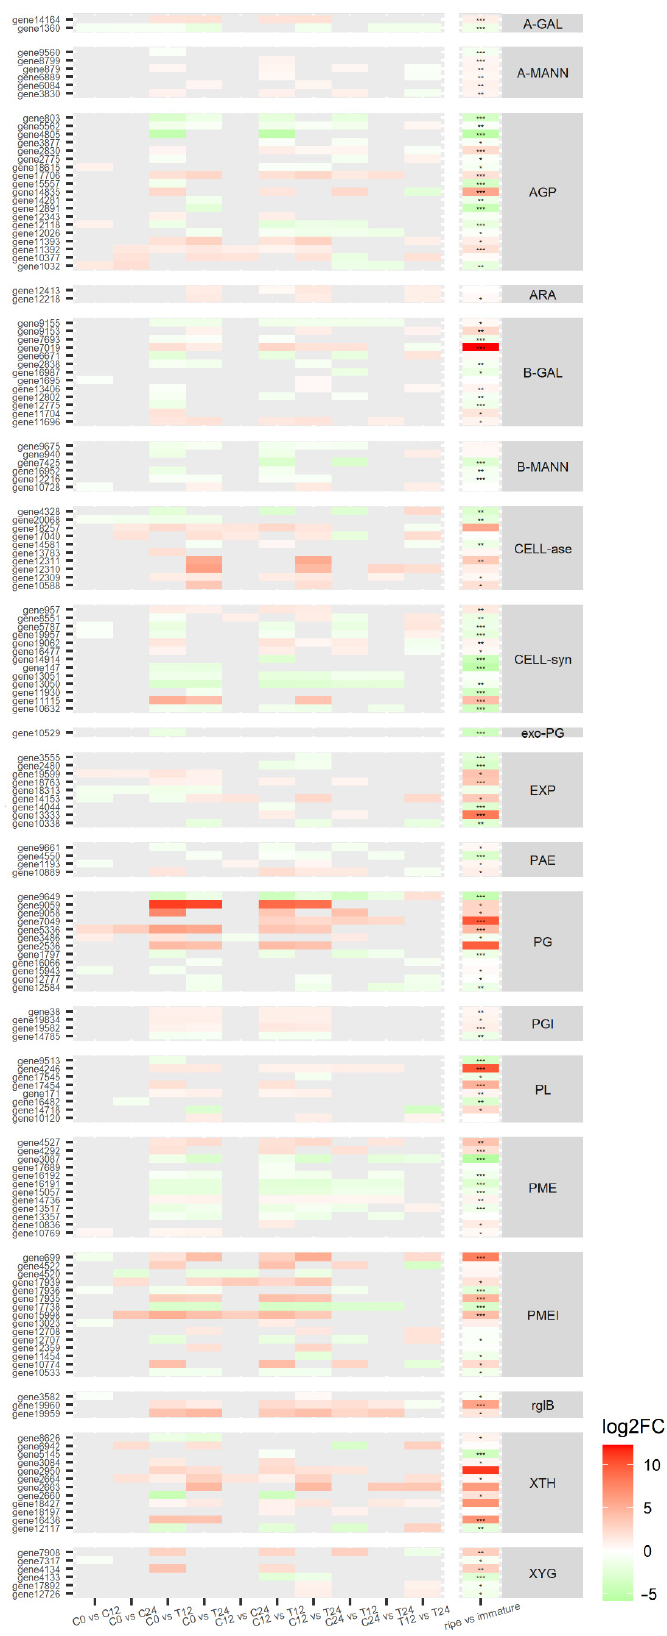
Figure 5. Heatmap of cell wall genes differentially expressed. Heatmaps of the expression levels of the gene coding for each enzyme related to the cell wall in both authorial transcriptomics